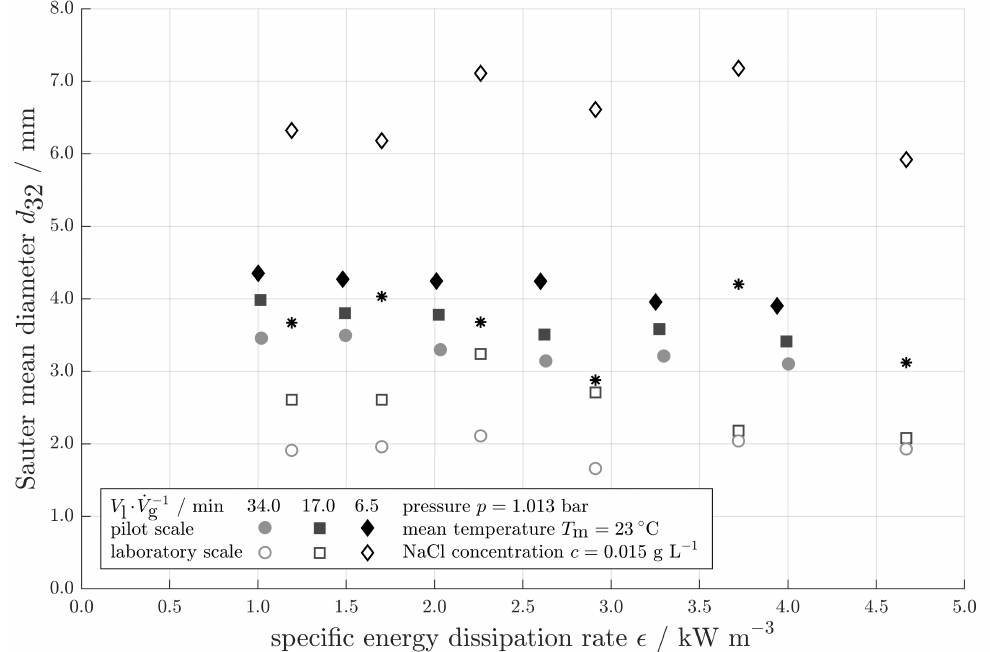
Figure 5. Sauter mean diameters d 32 in the pilot and laboratory setups for different specific gassing rates V l · ˙ V − 1 g and specific energy dissipation rates (cid:101) . Asterisks (*) denote data points obtained for the highest gassing rate in the laboratory setup from which outliers due to coalescence have been